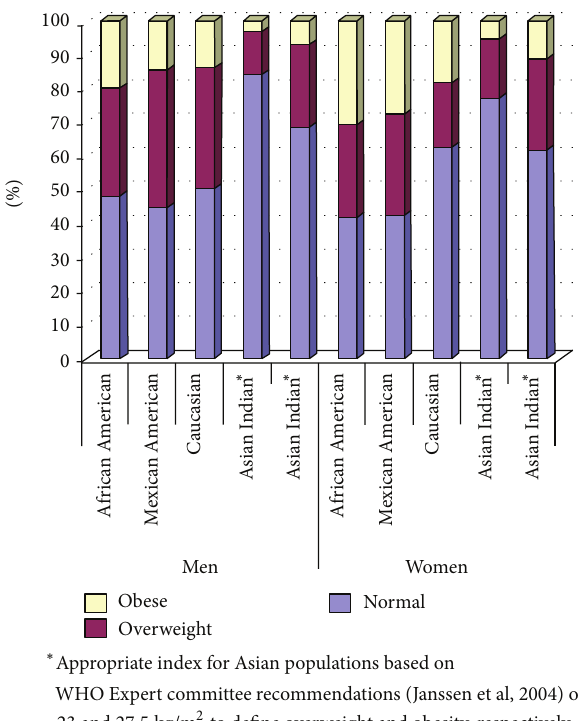
Figure 1: BMI categories stratified by ethnicity and